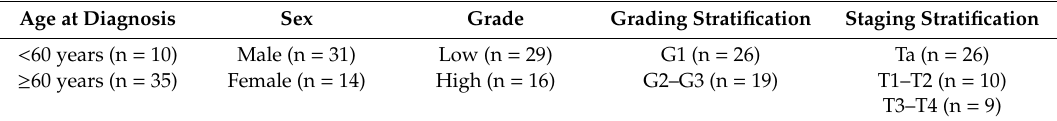
Table 1. Clinical and histopathological features of bladder cancer